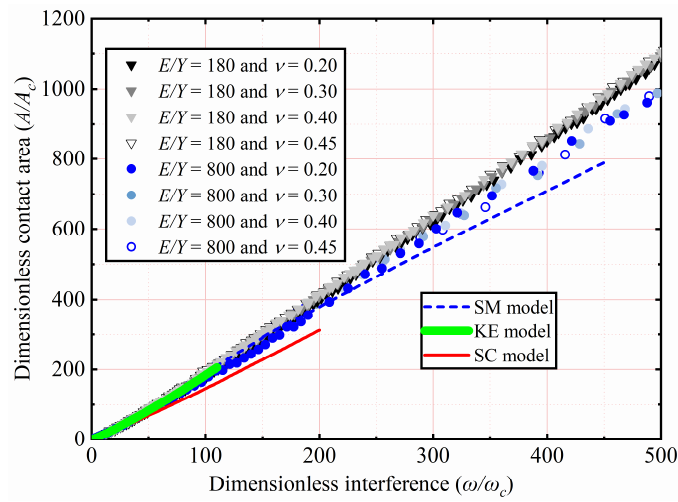
Figure 7. A / A c as a function of ω / ω c for different E and ν .